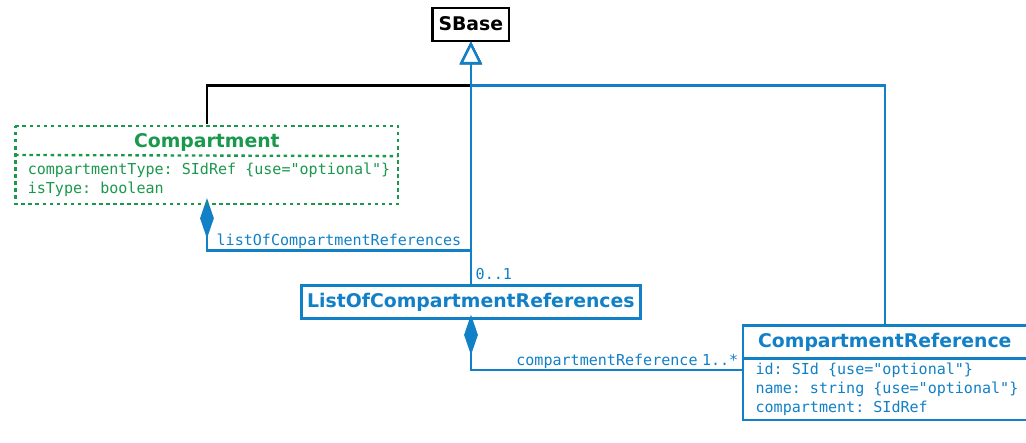
Figure 2: The definitions of Compartment , ListOfCompartmentReferences and